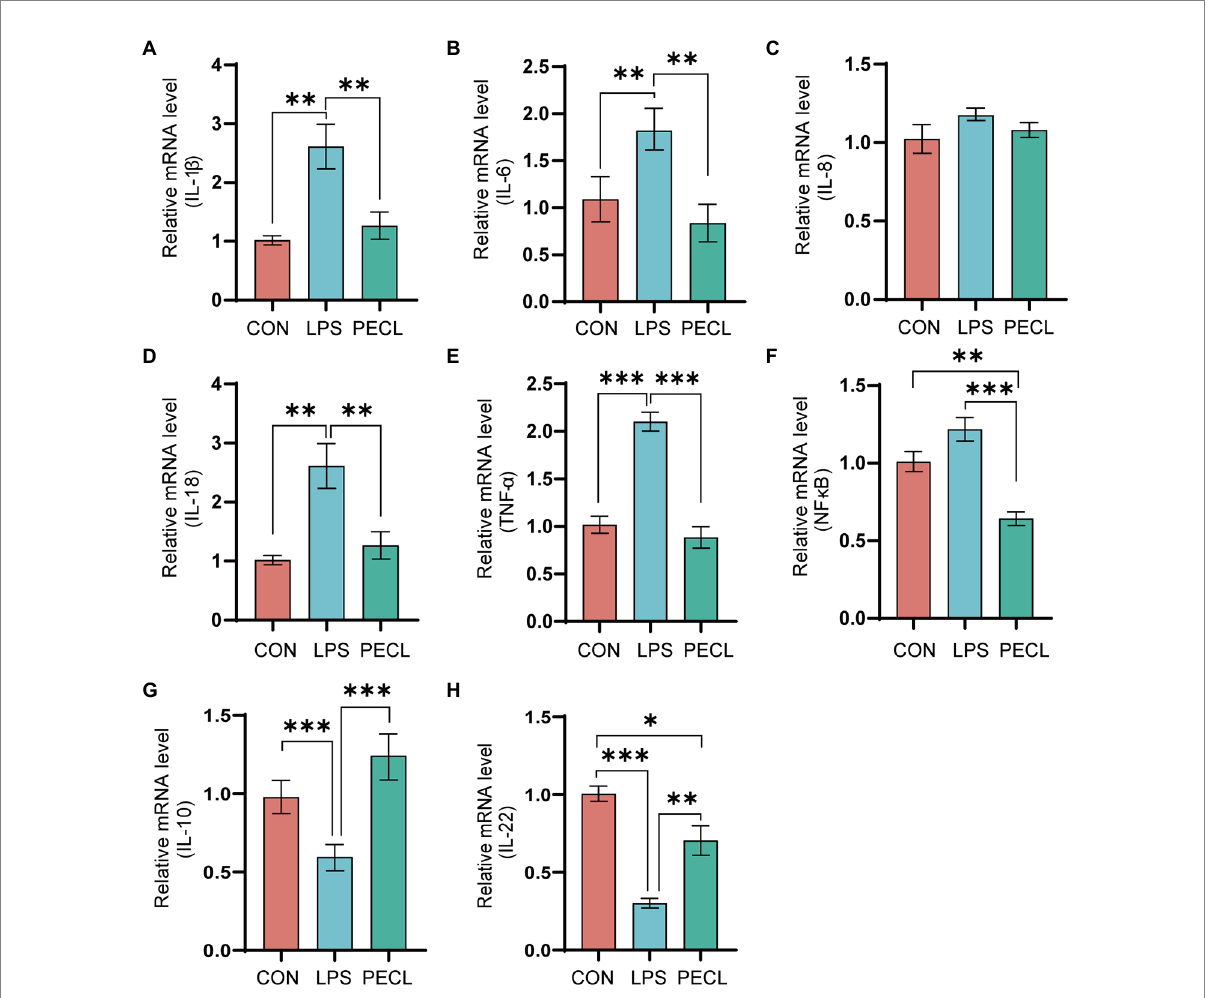
FIGURE. 2 Effects of dietary pectin on inflammatory cytokines in cecum. The fold change in mRNA expression relative to β -actin for (A) IL-1 β , (B) IL-6 , (C) IL-8 , (D) , IL-18 , (E) TNF- α , (F) , NF- κ b , (G) IL-10 , (H) IL-22 is shown. Signification is presented as * p < 0.05, ** p < 0.01, and *** p < 0.001; data are presented as the mean ± SE ( n =